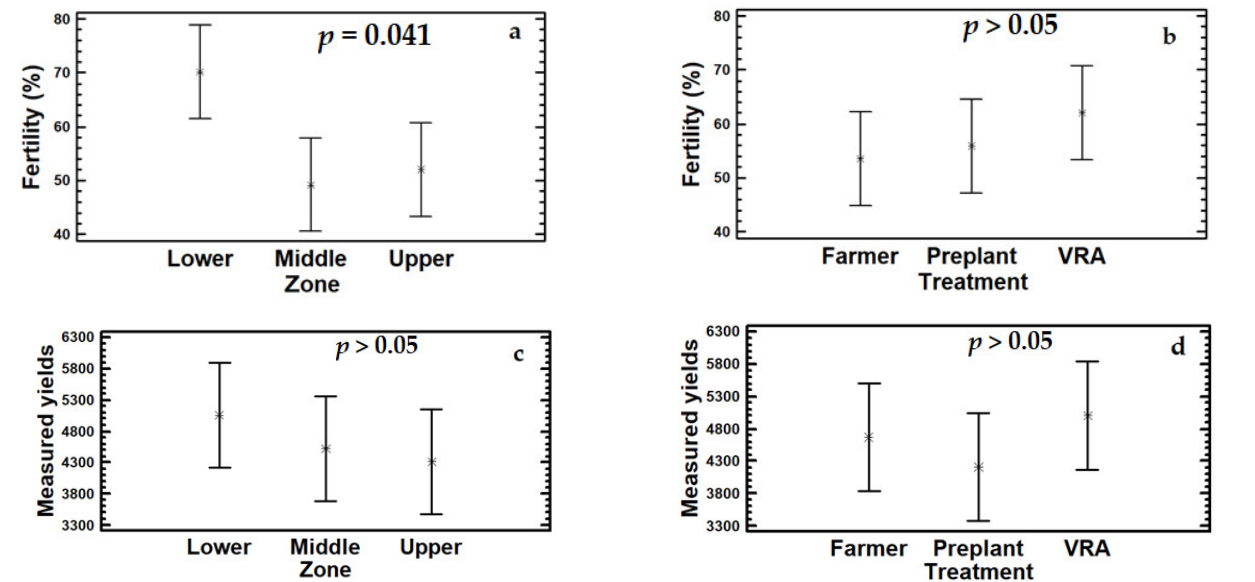
Figure 8. Fertility factor in the three zones of the field (%) and for the three treatments (%), respec- tively ( a , b ). Measured yields for the three field zones (kg/ha) and for the three treatments (kg/ha), respectively ( c , d ).